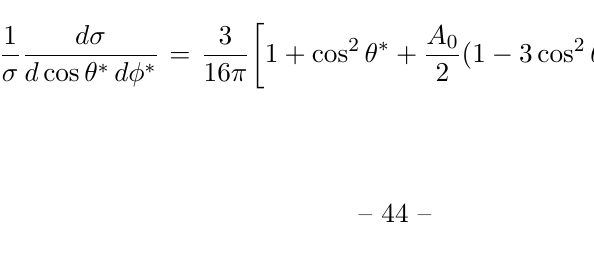
Figure 16 . W + H di(cid:11)erential cross section with respect to (cid:30) (cid:3) at line), and in the presence of dimension-six